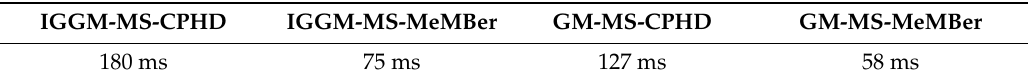
Figure 5. Estimation of the cardinality.